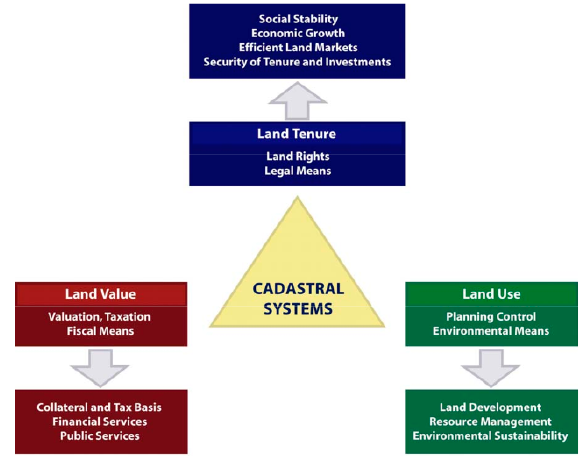
Figure 1. The nexus among cadastral system, land use, land value, and land tenure [8].